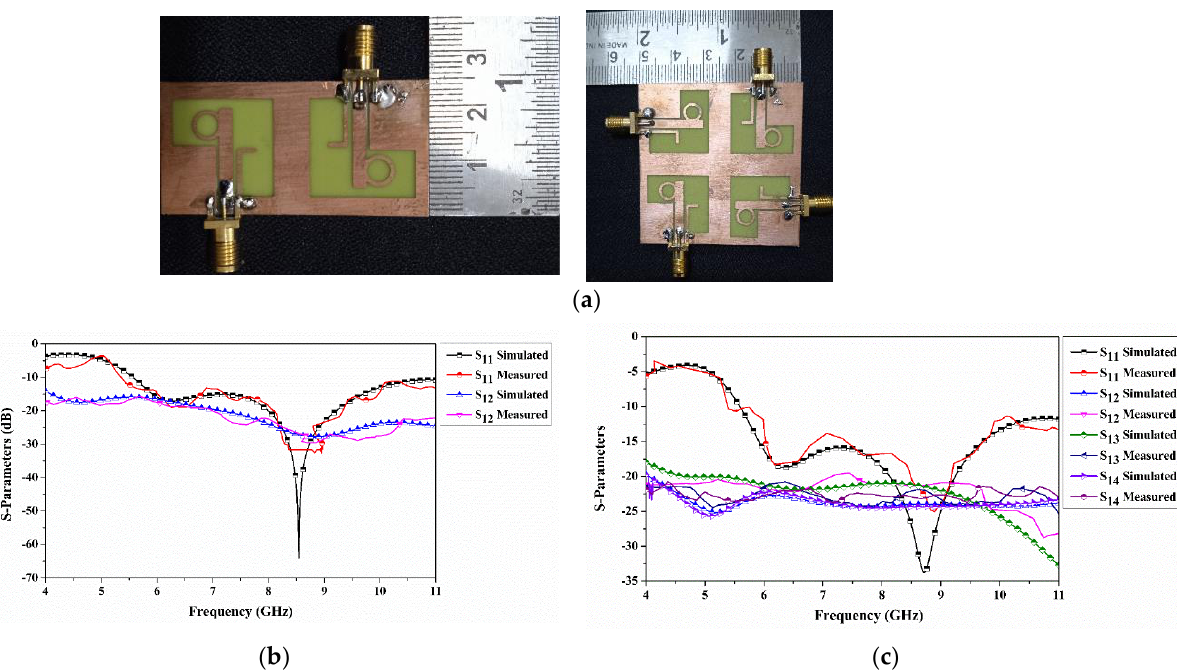
Figure 7. ( a ) Antenna prototype, ( b ) Dual-port S-parameters, and ( c ) Quad-port